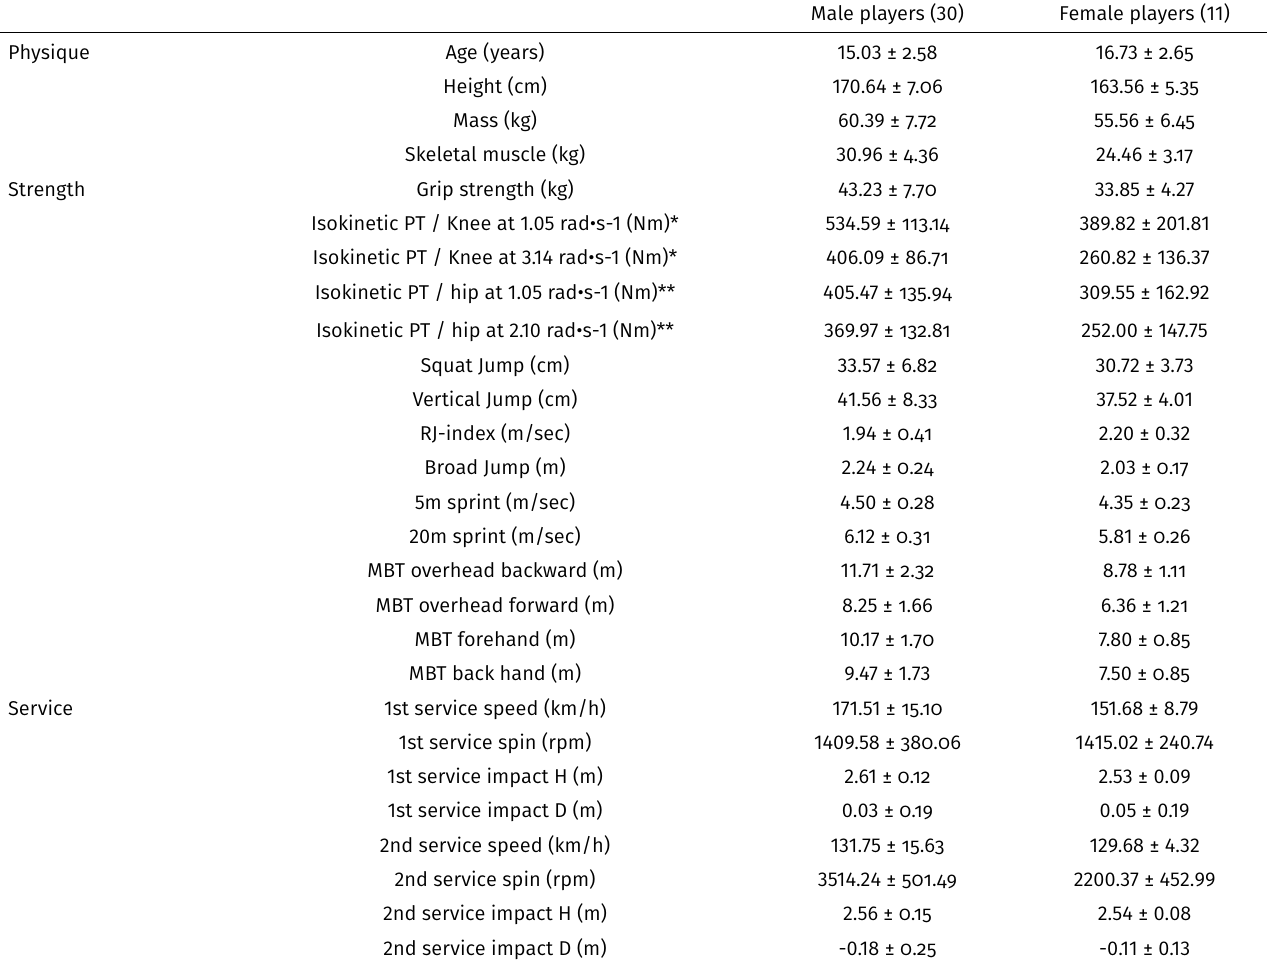
Table 2-1. The partial correlation coefficient of physique and physical strength versus service performance in male players.